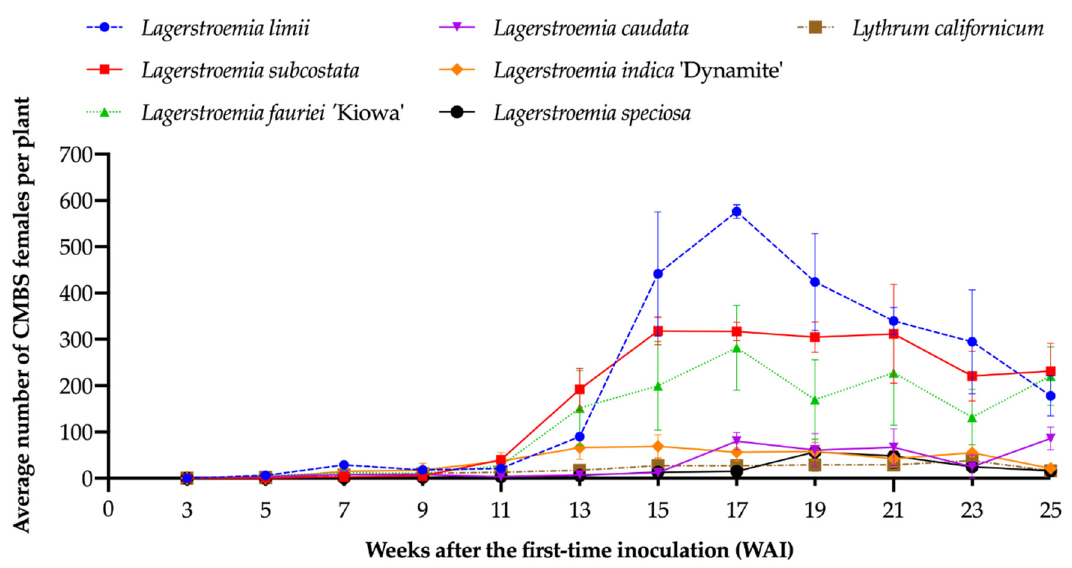
Figure 4. Changes of the average number (Mean ± SE) of CMBS females that emerged on six Lagerstroemia species and Ly. californicum over 25 weeks.